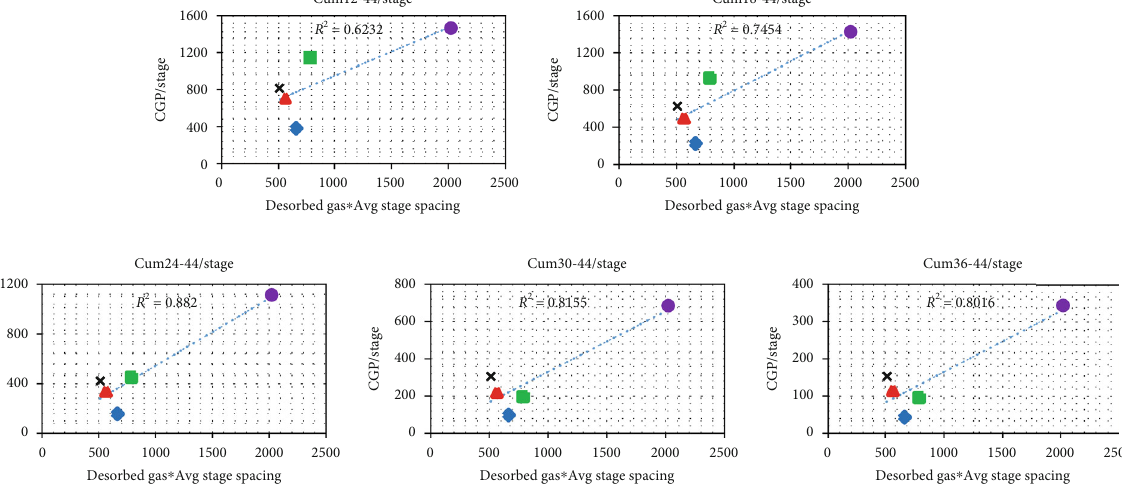
Figure 13: Desorbed gas ∗ average stage spacing versus cum gas per fracture stage cross-plots. Horizontal length was divided into stages, and its average length was multiplied to estimated desorbed gas volume. The gas production amounts were divided by stages. The correlation coe ffi cient slightly increased toward the end stage of gas production. Each mark represents the well use for the comparison and included in Tables 4 and 5. R 2 represents correlation coe ffi